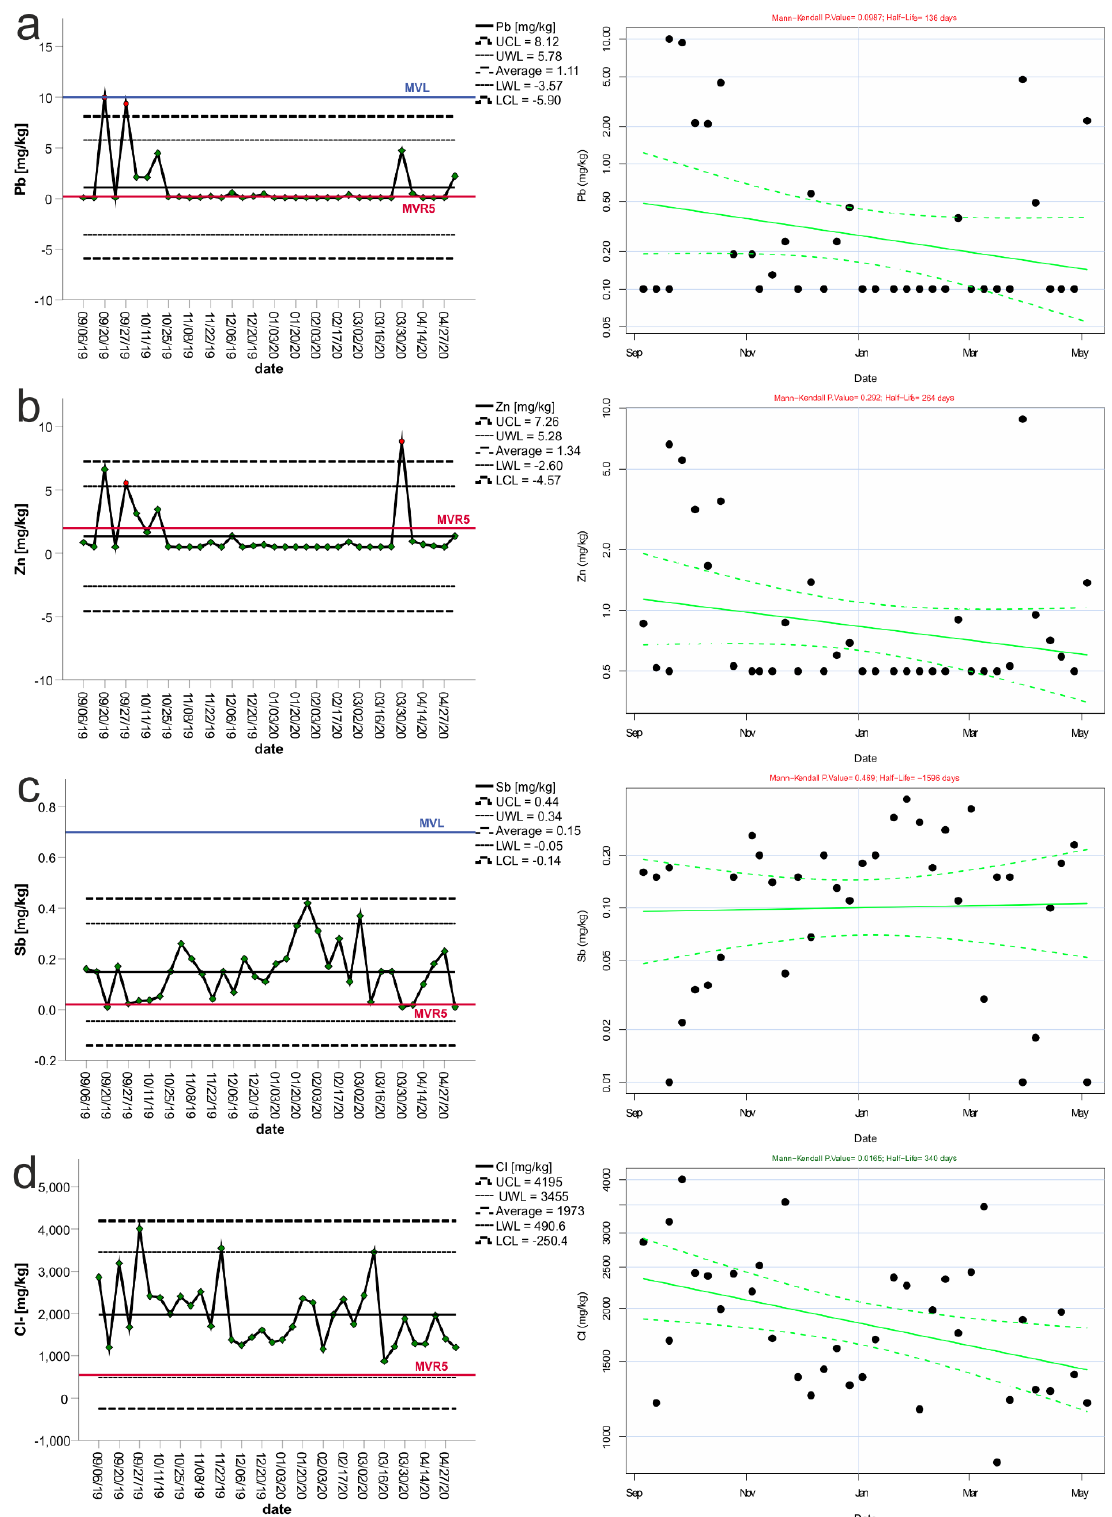
Figure 2. Control charts and trend analysis results for ( a ) Pb, ( b ) Sb, ( c ) Zn, and ( d ) Cl − .